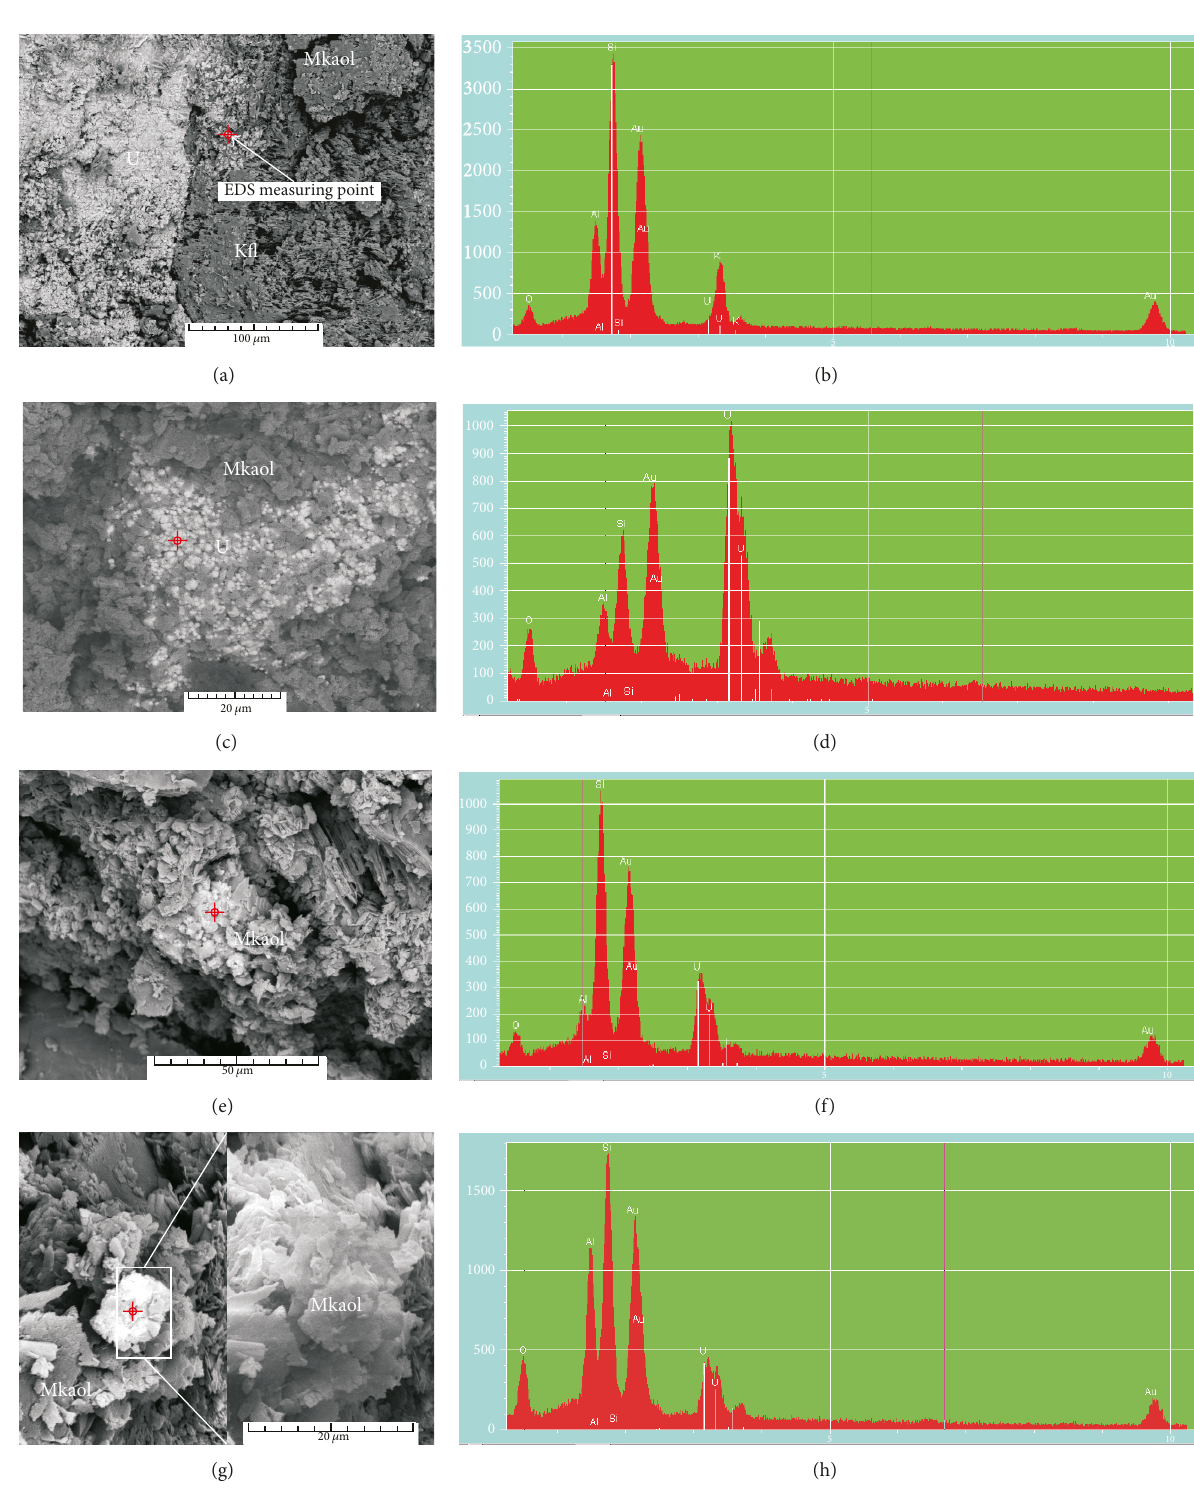
Figure 5: (a) Uranium minerals and micritic kaolinite filling-in leached pores of K-feldspar. (b) EDX analysis of area in (a). (c) Grape-like uraninite imbedded in stacks of micritic kaolinite. (d) EDX analysis of area in (c). (e) Micritic kaolinite adsorbing uranium (white area). (f) EDX analysis of area in (e). (g) Micritic kaolinite stack adsorbing uranium (white area). (h) EDX analysis of area in (g). Mkaol: micritic kaolinite; U: uranium mineral; Kfl: